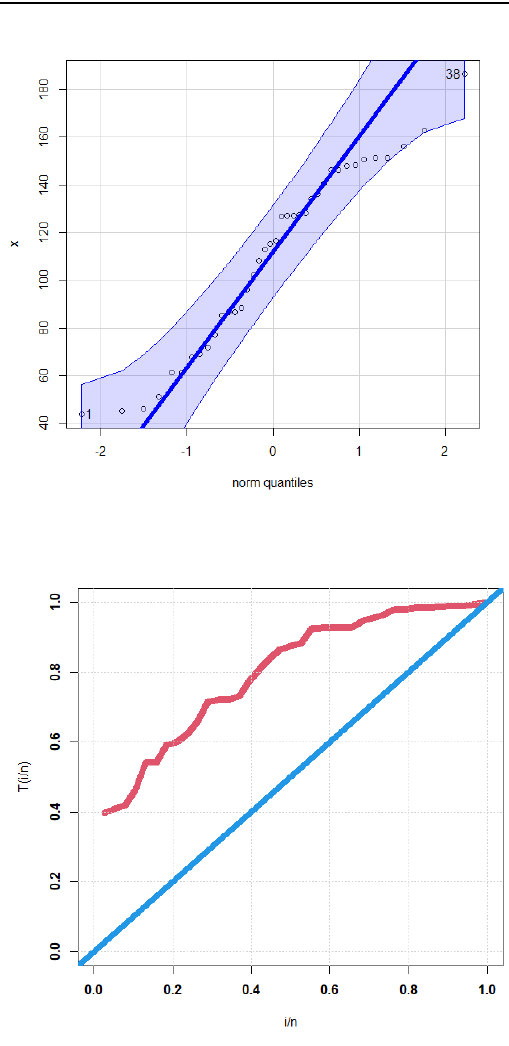
Figure 4. TTT Figure 4. TTT plots.